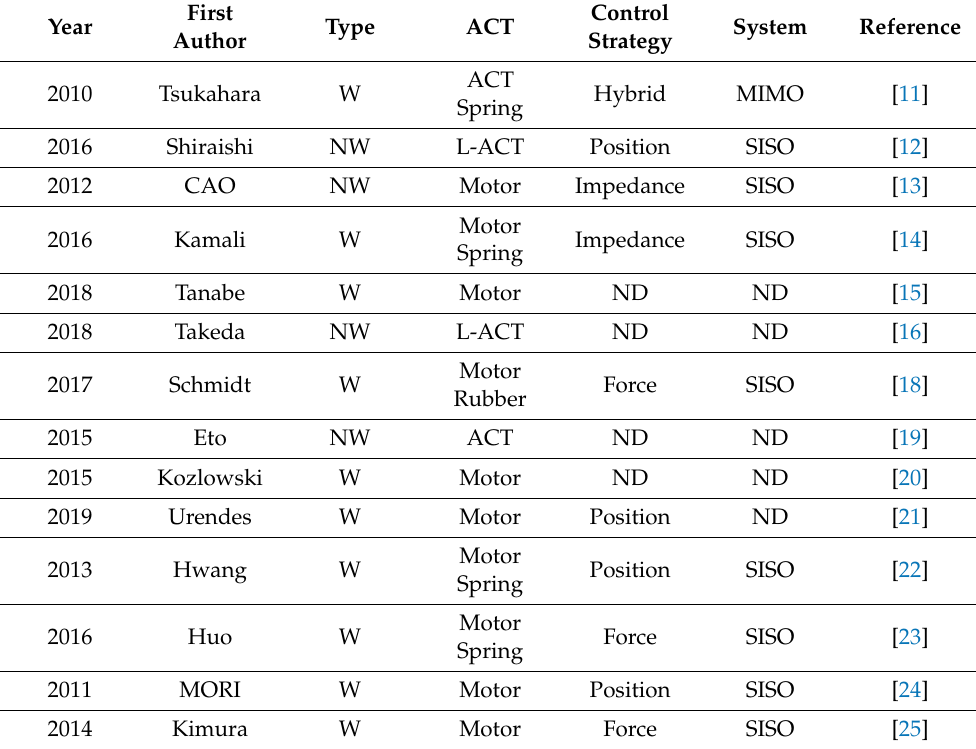
Table 3. Summary of the assistance forms and control of the